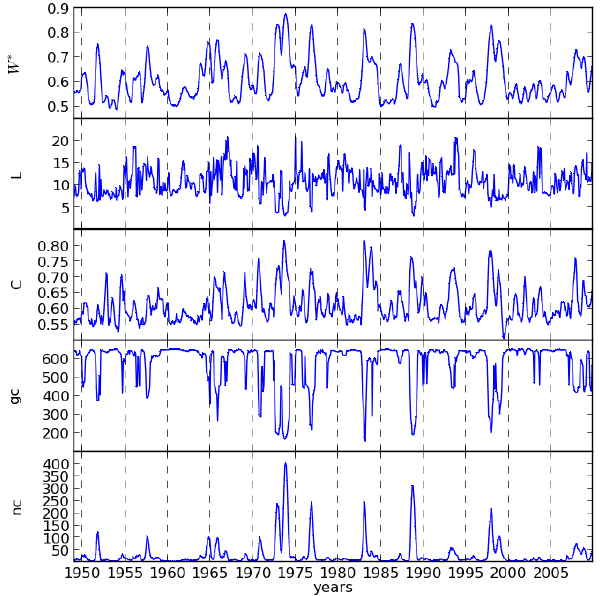
ENSO subgraph. Fig. 11. Evolution of the graph-theoretical properties of the extra-